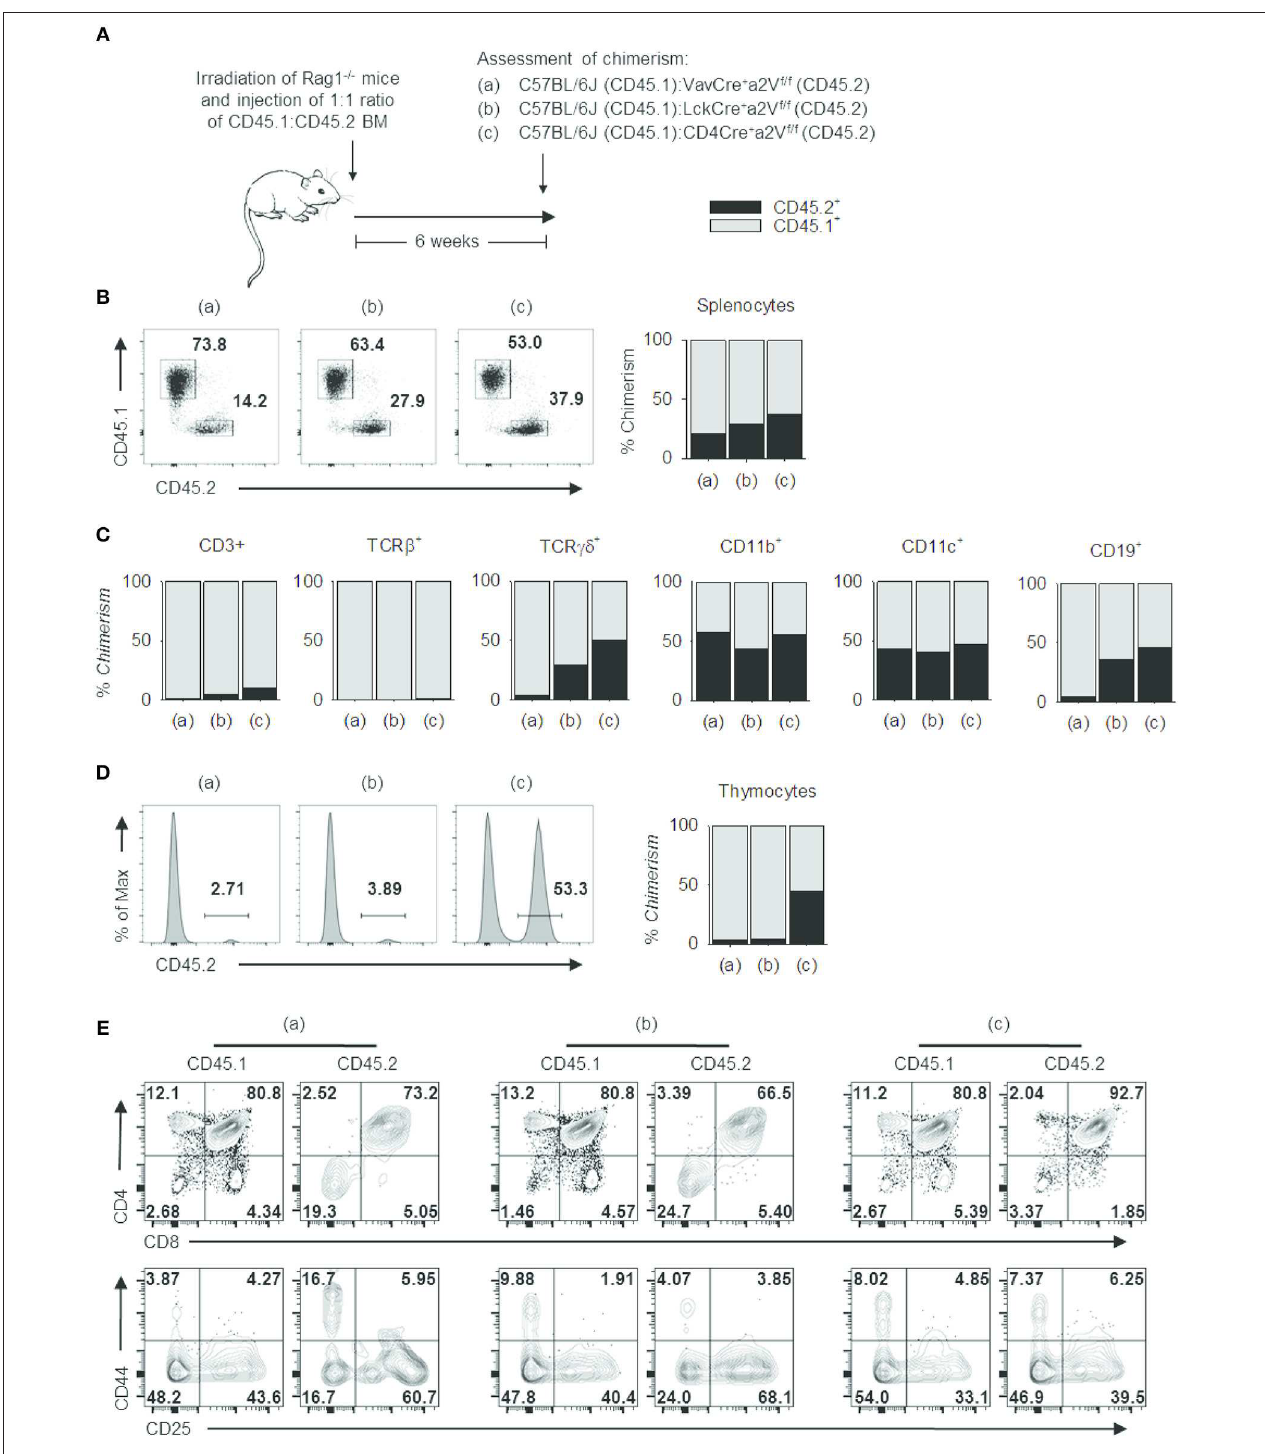
FIGURE 7 | Cell intrinsic deficits in the development of a2V-deficient T cells. (A) Schematic representation of experimental design. (B) Representative flow cytometry and graphical representation of overall chimerism of splenocytes in experimental mice. (C) Graphical representation of % chimerism of immune cell subsets isolated from mouse spleens. (D) Representative flow cytometry and graphical representation of % chimerism in mouse thymuses. (E) Flow cytometry of thymocyte subsets in CD45.1 WT and CD45.2 a2V-KO donor cells. Data are representative of 2 independent experiments [ n = 4, (groups a & b); n = 3 (group c)]. Numbers in flow plots represent frequencies within quadrants or